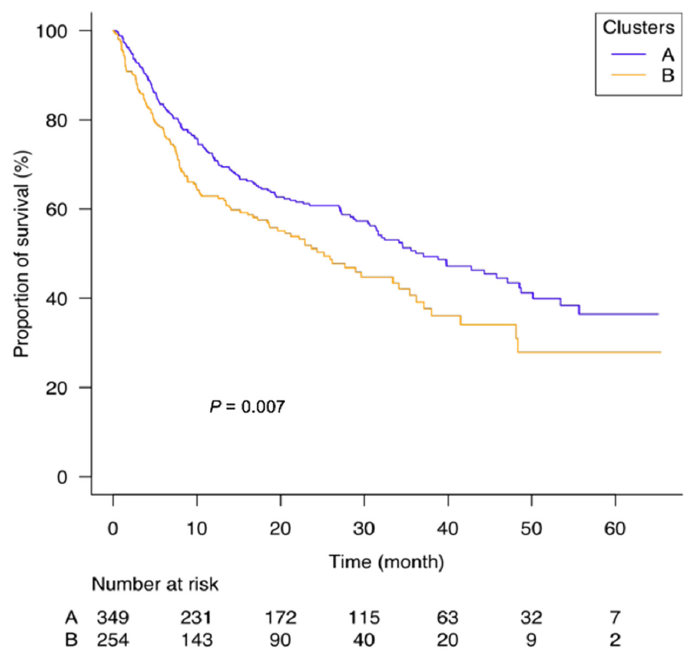
Figure 3. Kaplan–Meier survival curves for long-term mortality among elderly cancer patients in relation to CAR